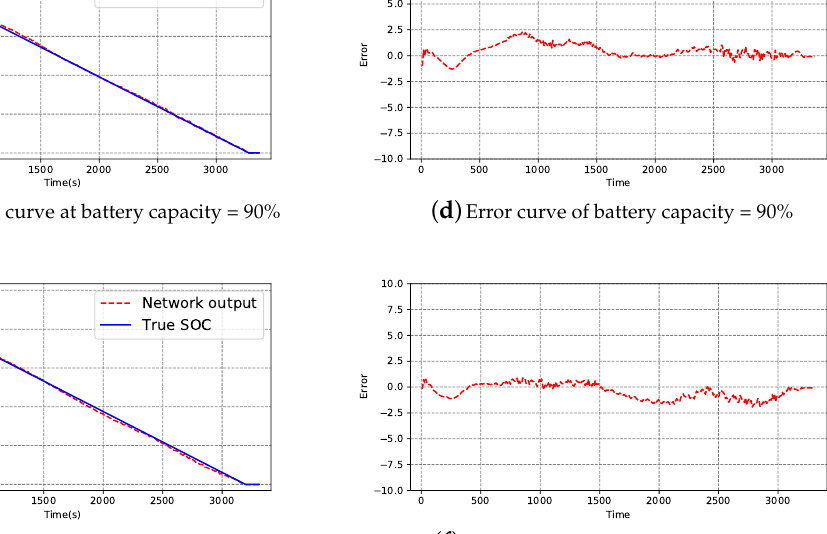
( f ) Error curve of battery capacity = 85% Figure 11. Estimation results at 25 ◦ C (1).